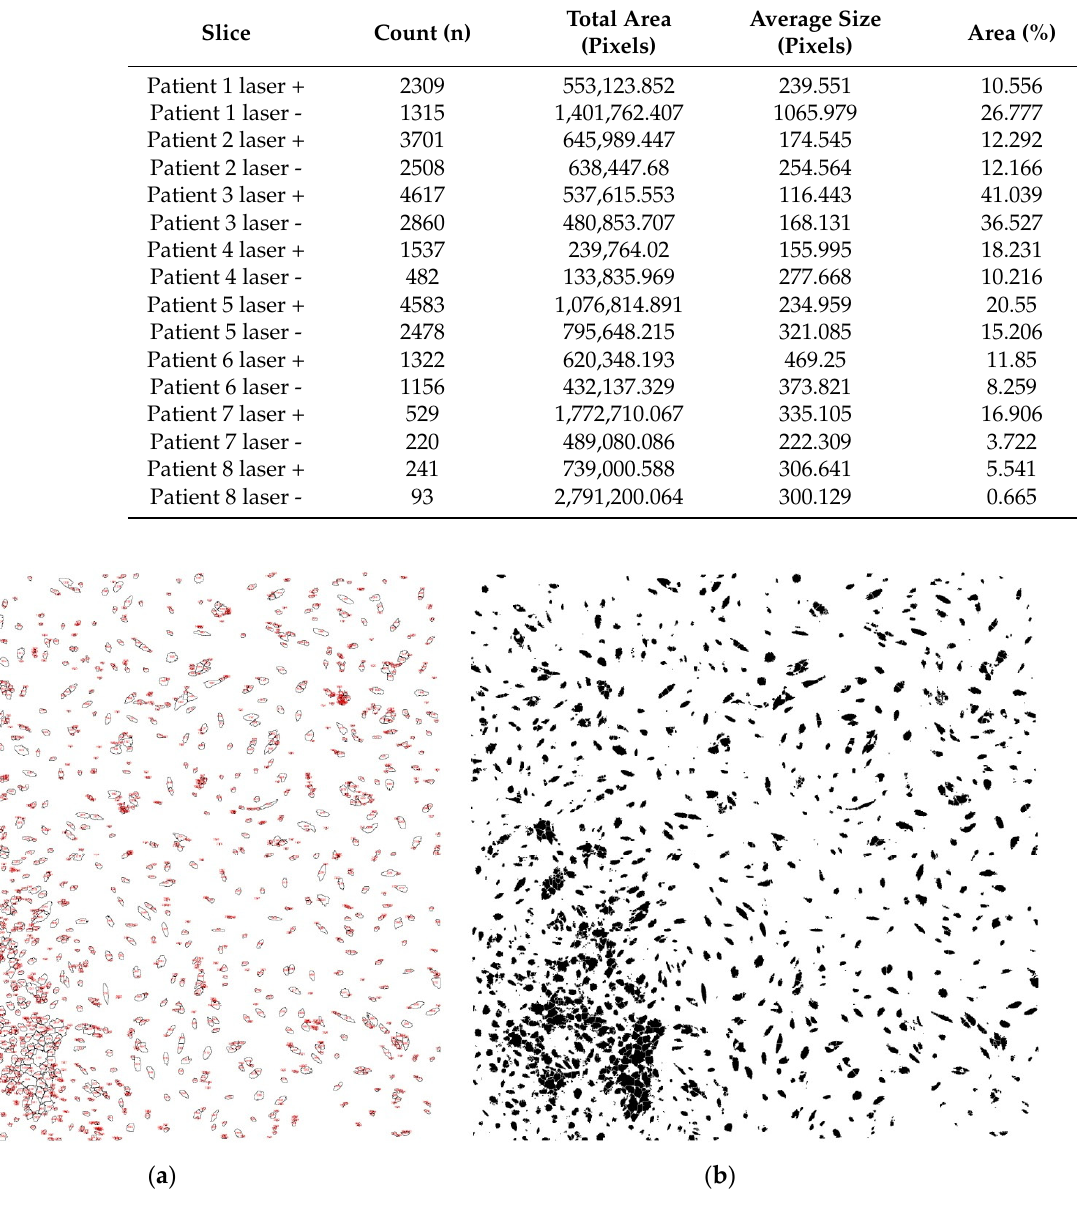
Figure 3. Quantification of cell proliferation (laser “+”): ( a ) cell counting ( b ) binary